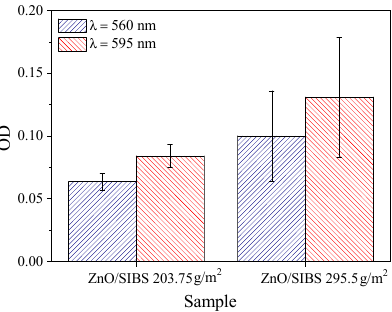
Figure 8. OD values of P. aeruginosa biofilms on the fiber mats.